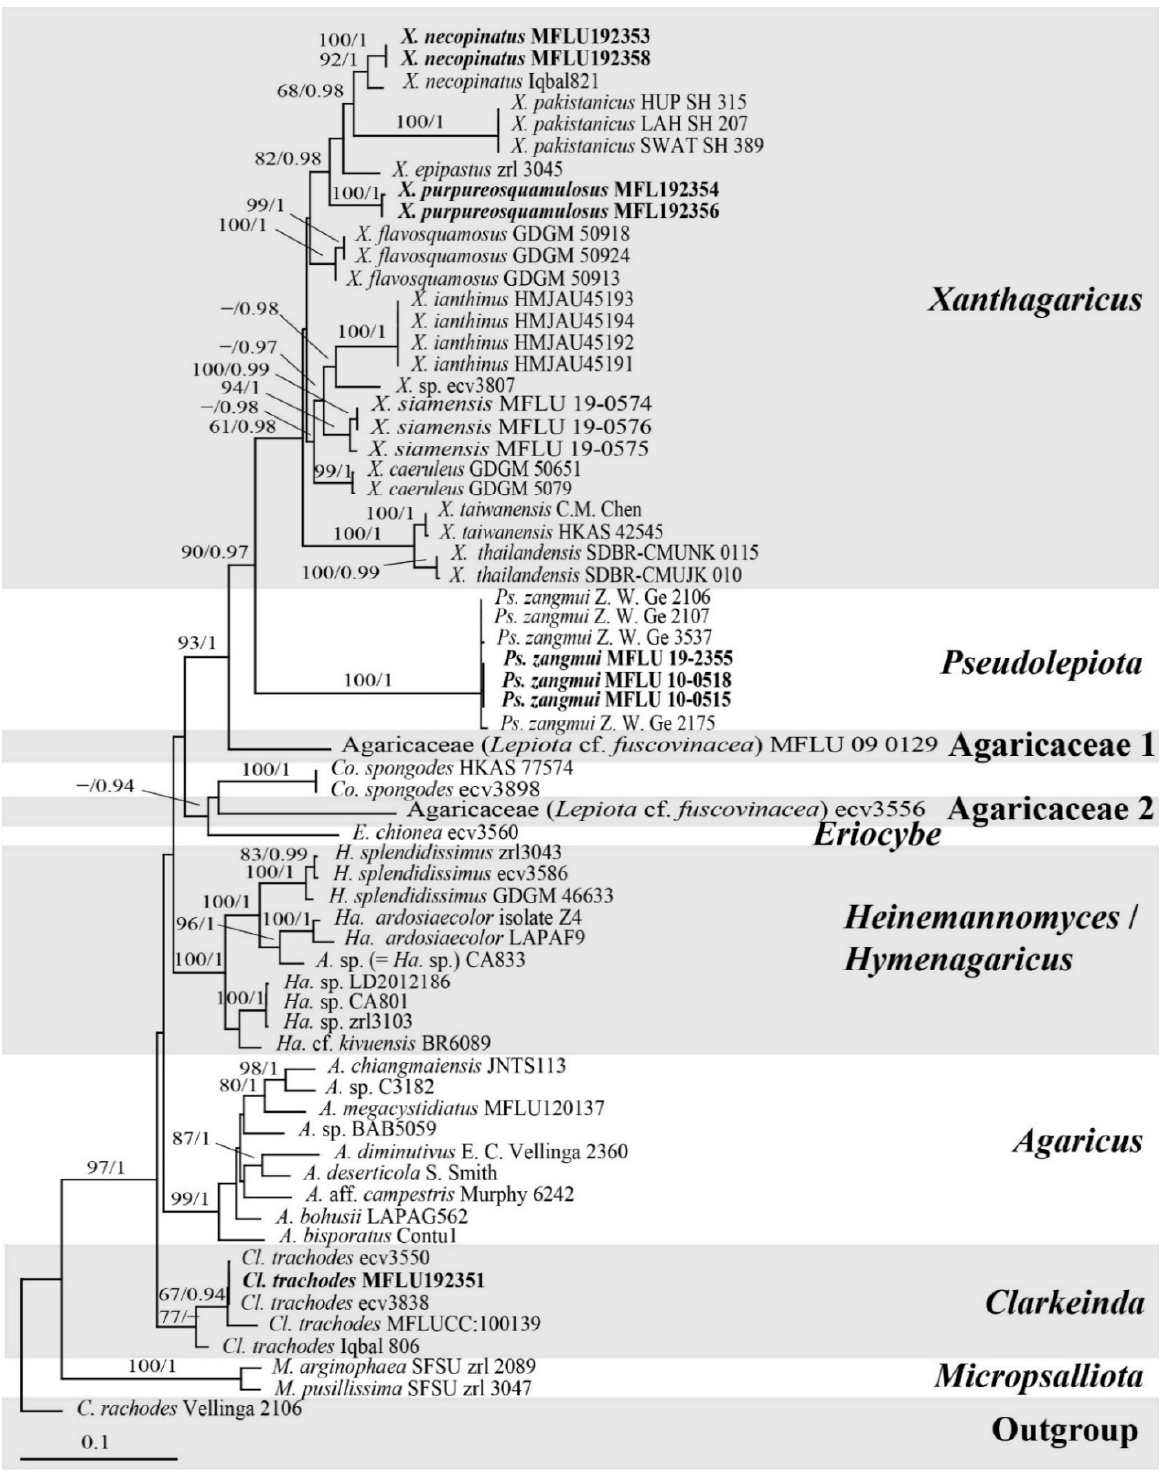
Figure 1. Maximum likelihood phylogenetic tree of the Agaricus clade in the Agaricaceae based on nrITS-LSU sequence data. New sequences generated from Thailand are in bold. Bootstrap values (ML/B) are given above the branches. Bootstrap values for maximum likelihood equal to or greater than ≥ 60 and Bayesian posterior probabilities ≥ 0.95 are placed above the branches. Genus abbreviations are as follows: A = Agaricus , C = Chlorophyllum , Cl = Clarkeinda , Co = Coniolepiota , E = Eriocybe , H = Heinemannomyces , Ha = Hymenagaricus , Ps = Pseudolepiota , M = Micropsalliota , and X = Xanthagaricus . Chlorophyllum rachodes Vellinga is an outgroup.